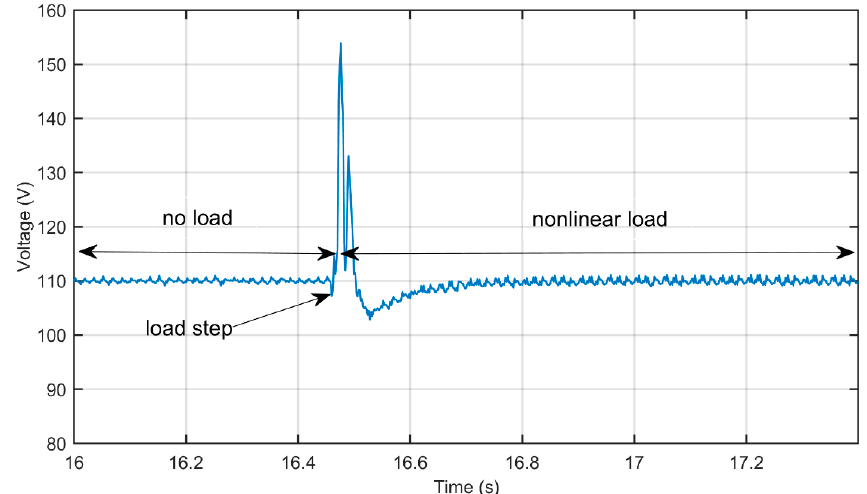
nonlinear load ( η = 7.8, R nl = 200 Ω , L nl = 10 mH, C nl = 2200 µ F THD = 3.1%). nonlinear load ( η = 7.8, (cid:1844) (cid:3041)(cid:3039) = 200 (cid:2007), (cid:1838) (cid:3041)(cid:3039) = 10 (cid:1865)(cid:1834), (cid:1829) (cid:3041)(cid:3039) = 2200 (cid:2020)(cid:1832) THD = 3.1%).